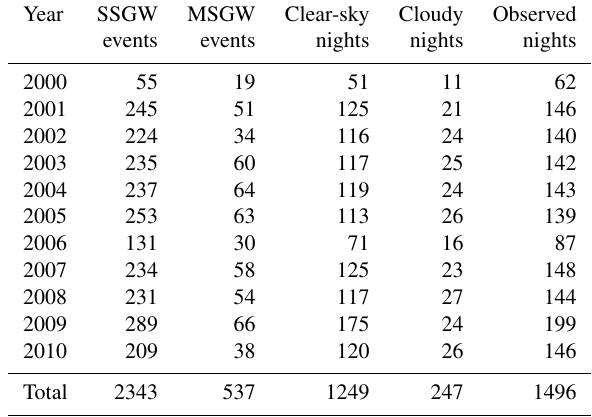
Table 1. The yearly distribution of the SSGW and MSGW events, clear-sky, cloudy, and observed